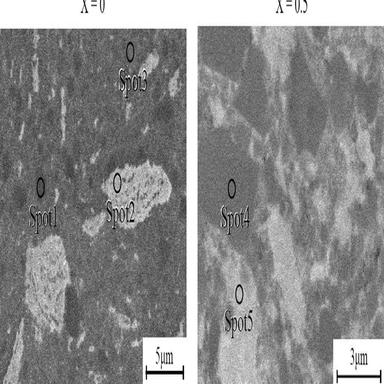
SEI images TiCXN1-X-TiCrNbMoTa composites for EDS spot analysis (a) X = 0 (b) X = 0.5 (c) X = 0.7 (d) X = 1.0.